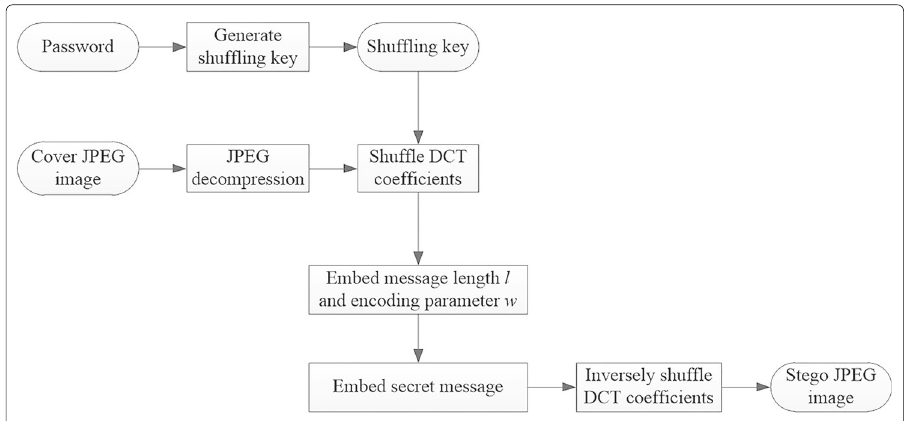
Fig. 1 Embedding procedure of F5